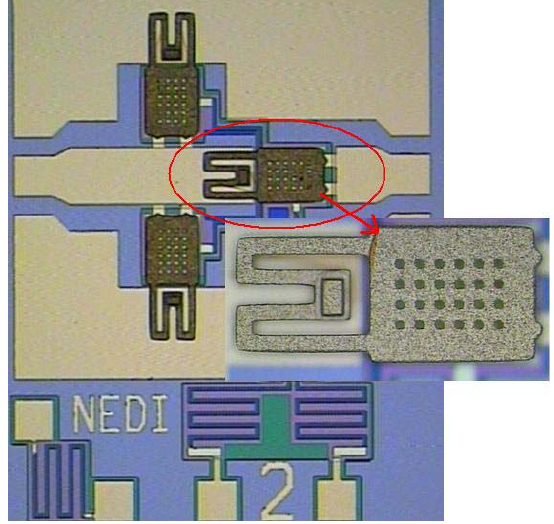
Figure 6. Microphotograph image of the fabricated series-shunt switch.